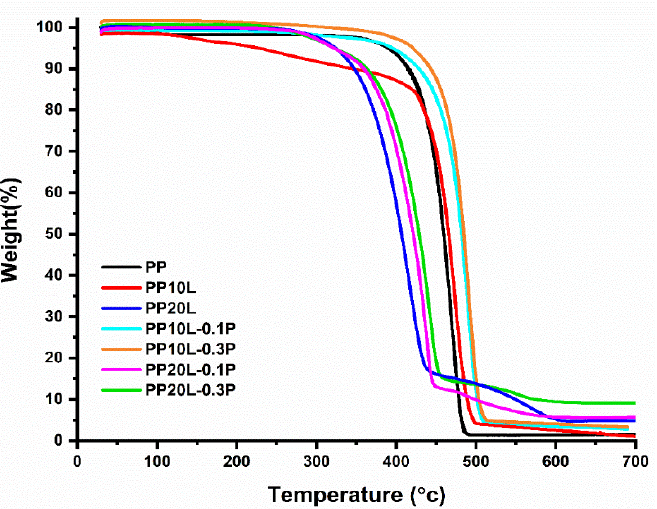
Figure 6. Thermal Gravity (TG) curves of polypropylene, polypropylene/lignin blend sponges, and their forms modified with POSS.